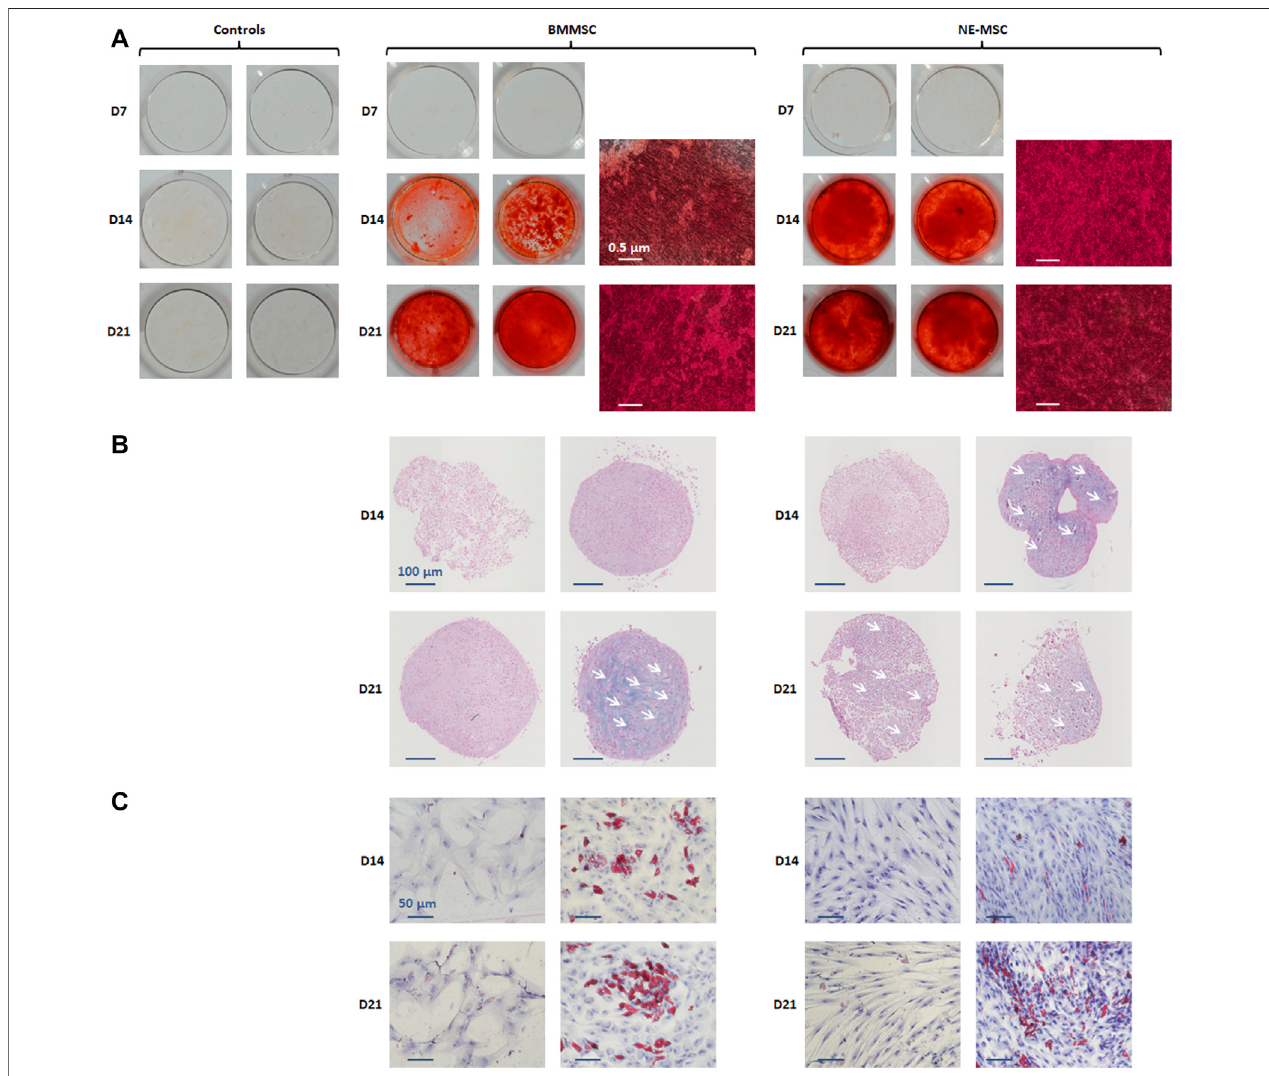
FIGURE 2 | In vitro assessment of multipotency. BMMSCs and NE-MSCs were induced to differentiate into osteoblasts (alizarin red, (A) , chondroblasts (alcian blue, (B) and adipoblasts (red oil, (C) ). Both BMMSCs and NE-MSCs displayed mineralization production at D14 (red cells). NE-MSCs differentiated in chondroblasts at D14 and BMMSCs at D21 (blue cells). BMMSCs and NE-MSCs also differentiated in adipoblasts at D14 (red cells).